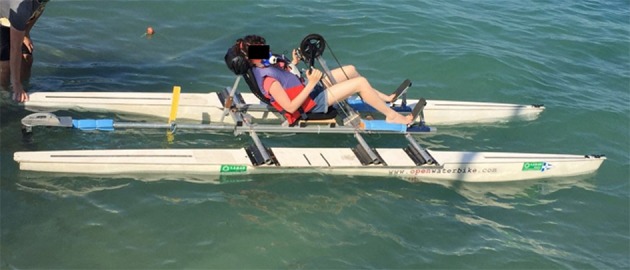
The Handwaterbike.